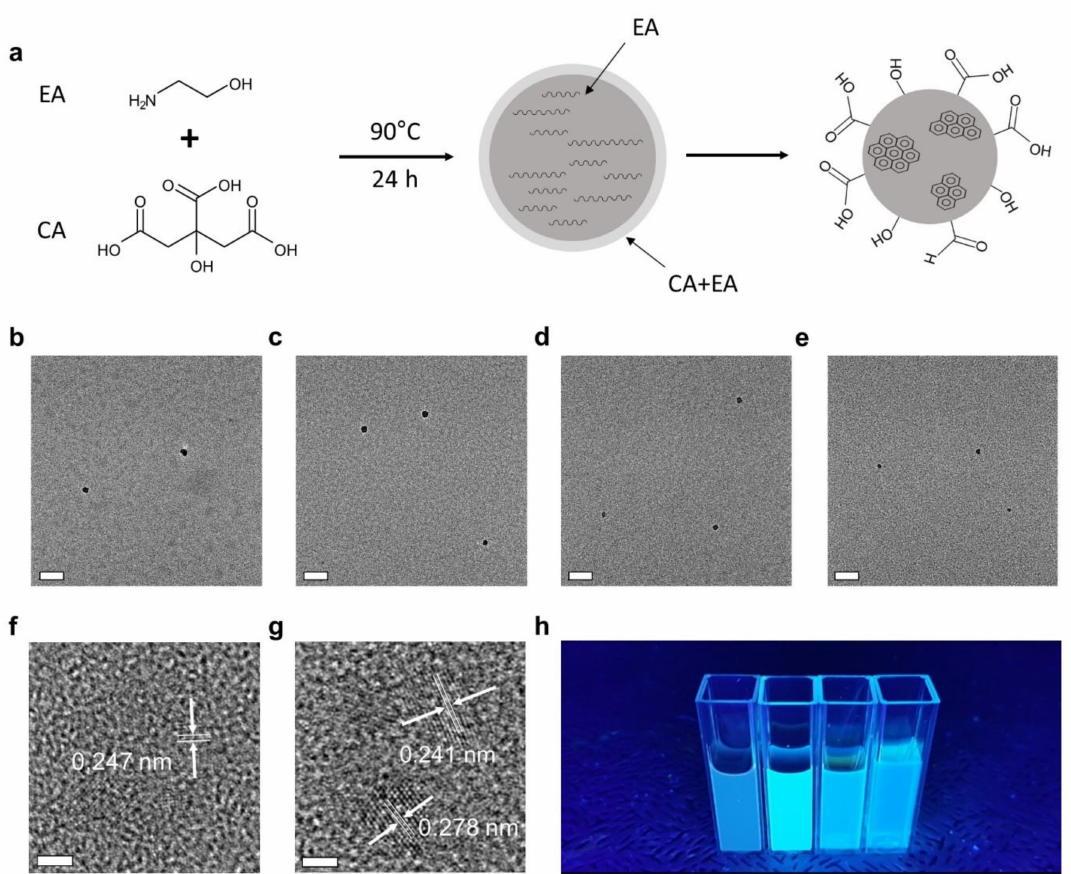
Figure 1. ( a ) Schematic illustration of the synthesis of CNDs. TEM images of ( b ) CND1, ( c ) CND2, ( d ) CND3, and ( e ) CND4. The scale bars represent 50 nm. ( f , g ) High-resolution TEM images of CDs. The scale bars represent 2 nm. ( h ) CND1–CND4 (left to right) under a 365 nm UV